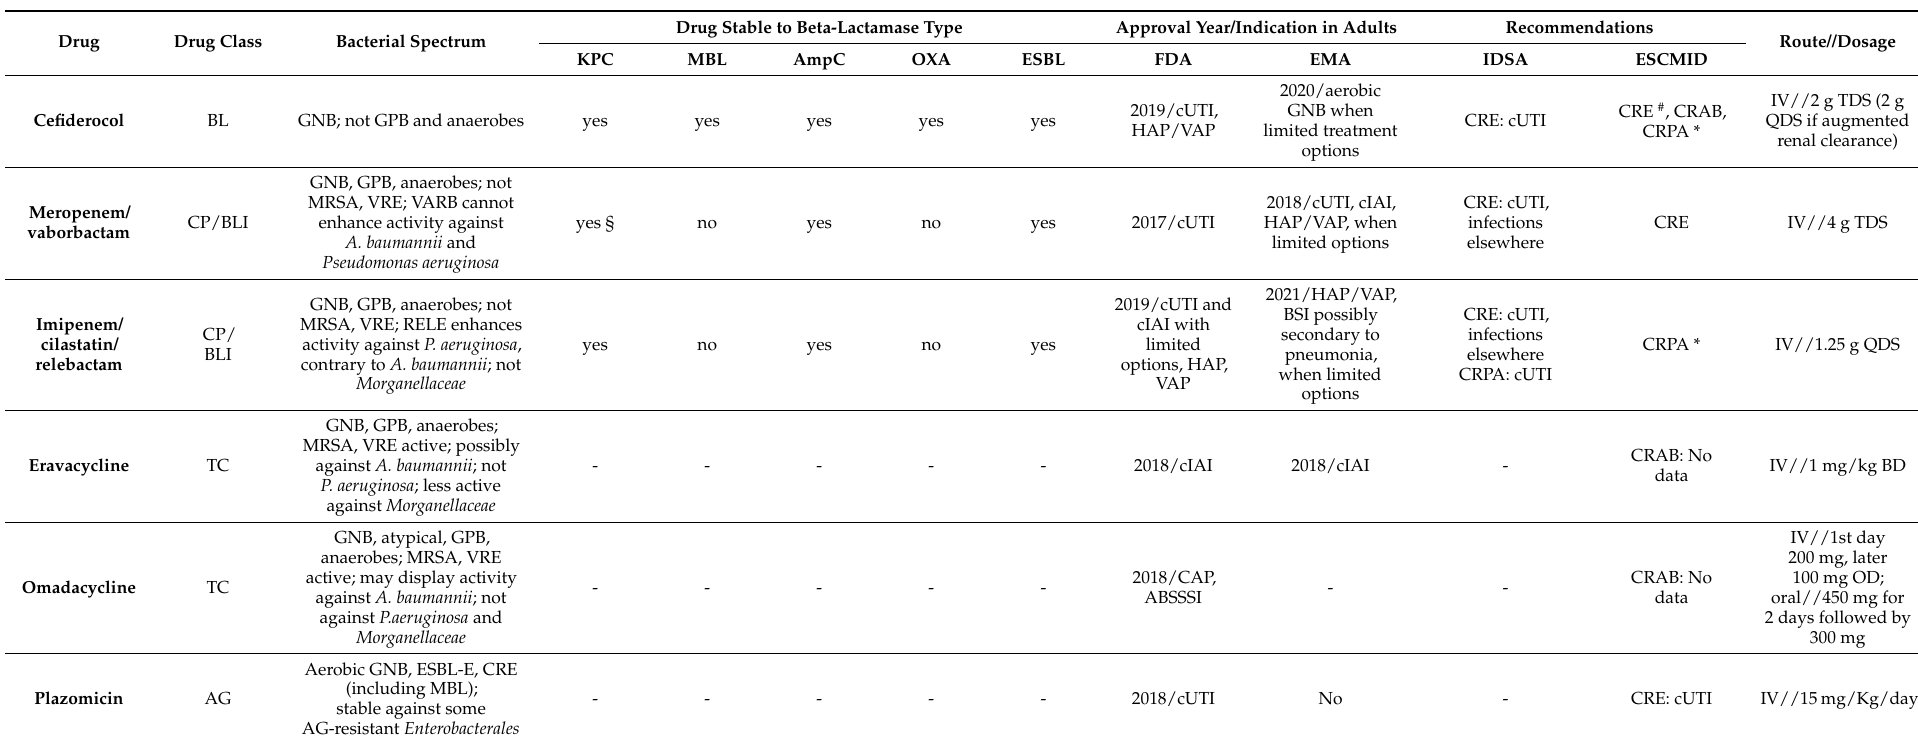
Table 1. Characteristics of novel approved anti-Gram-negative antimicrobial